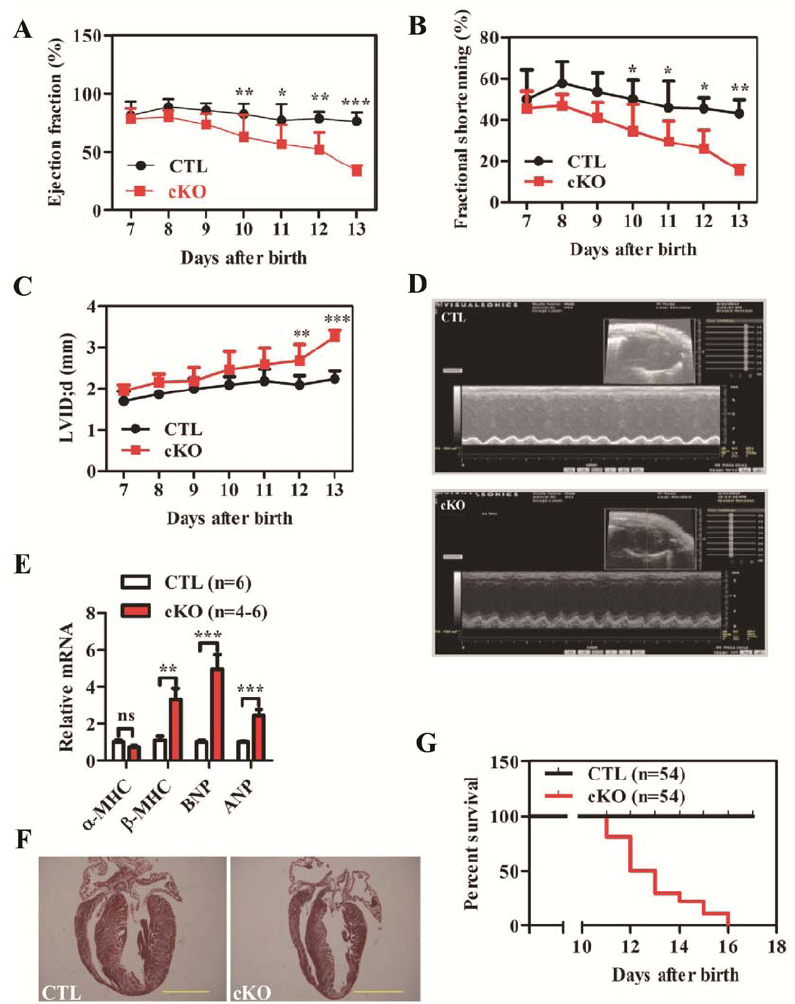
Figure 2. ( A – C ) Comparison of Ejection fraction (EF), Fractional shortening (FS) and LVIDd between cKO and CTL at different stages ( n = 8 at days 7–11, n = 5 at day 12 and n = 3 at day 13); ( D ) Representative echocardiography images at postnatal day 12; ( E ) qPCR detection of heart remodeling markers including α MHC , β MHC , BNP and ANP ( n = 4–6); ( F ) Masson’s staining (Scale bar = 1.5 mm); and ( G ) Survival analysis ( n = 54). Abbreviations: CTL, Control group ( Rheb1 F / F ); cKO, cardiac knockout group ( Rheb1 F / F